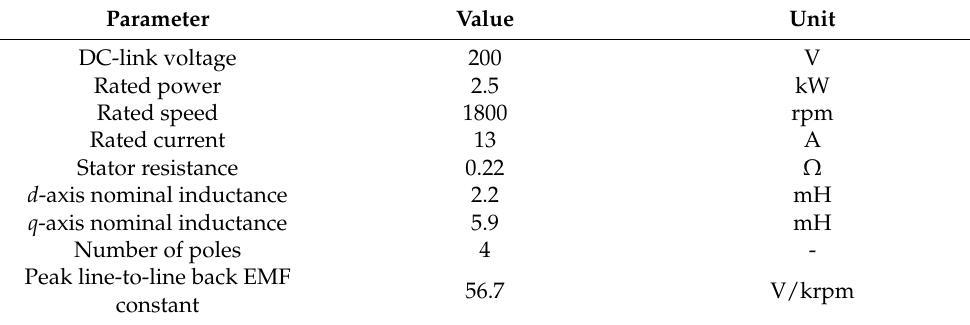
Table 1. Parameters of the IPMSM drive system used for simulation.